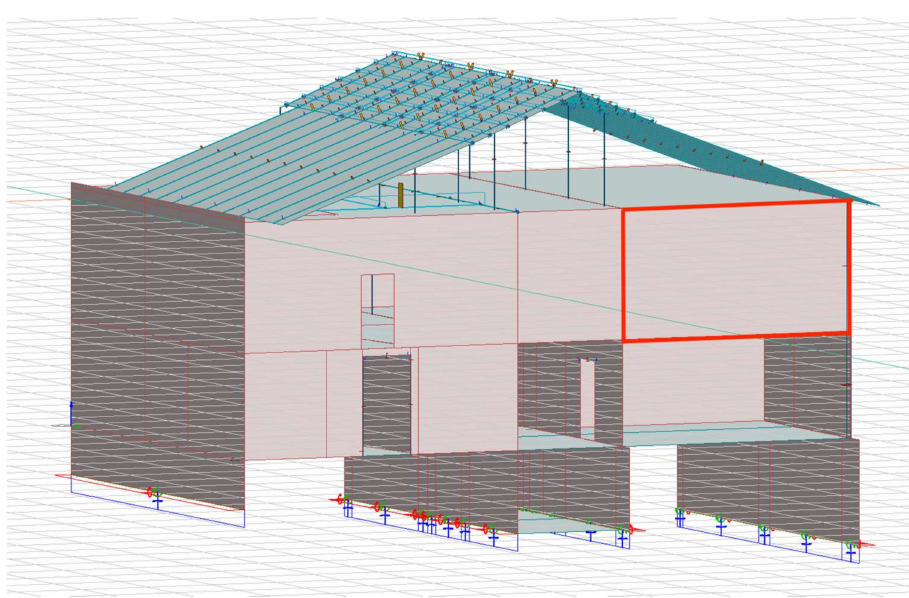
Figure 15. Building with section in axis V showing